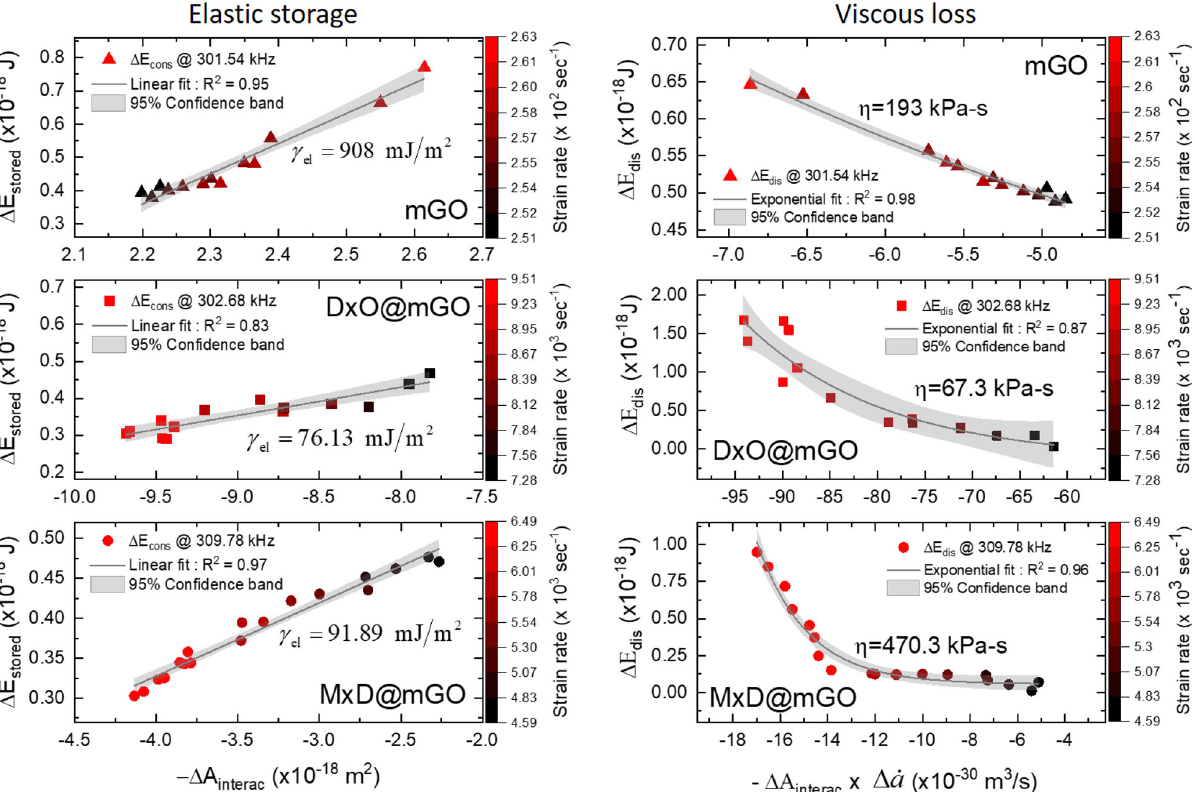
Fig. 4 Estimations of surface energy and viscosity coef fi cients from the dynamic responses. The exponential trend of dissipated energy clearly depicts a changing viscoelastic behavior as a function of strain rate. Error bars of the energy estimations from the experimental data are in the order of 1%. Error bars are computed from the standard deviations of individual measurands used to compute the energy estimates. The shaded area represents the 95% con fi dence band of the data fi ts. The estimated surface energy: γ el and viscosity coef fi cient: η indicate an intrinsic strength in the order of kPa for DxO and MxD on mGO systems at the operational fi xed perturbation rates (cid:7) 302 and 309 kHz, respectively. This is a relevant scale for biomolecules and tissues behaving like metallic glass 32,62 . MxD being a smaller molecule is expected to re fl ect a higher intrinsic strength at a comparable perturbation rate. Comparatively for mGO results indicate an intrinsic strength in the order of MPa that matches well to the previous literature 63 . Note: for mGO elastic deformation acts against the change in surface energy and thus the x -axis scale needs to be reversed in sign to correctly estimate as to the positive slope of the fi tting